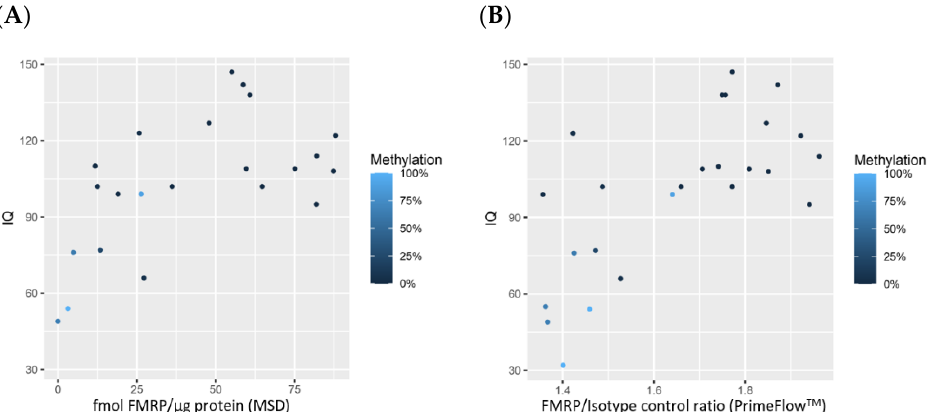
Figure 2. Scatterplot of FMRP expression measured by MSD ( n = 22) ( A ) and by Flow Cytometry ( n = 25) ( B ) by IQ. Points are colored by % methylation, with lighter blue corresponding to more methylation and darker blue to less methylation. A small amount of random jitter is applied to the x-axis in order to better display overlapping points.